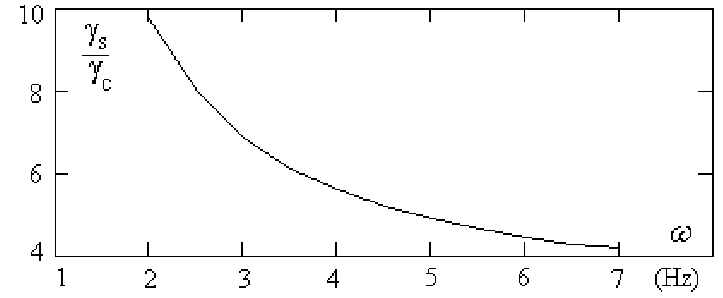
Fig. 4. The ratio γ s / γ c versus ω for EMIC waves in the hydrogen 1-D and 2-D plasma models. According to Eqs. (75-77), the PCI growth rate γ , as well as the imaginary part of the c transverse dielectric permittivity, is calculated by the summation of the contributions of the separate bounce resonant terms to . The typical structure of the bounce resonance terms , Eq. (77), is shown in Fig. 5 for the different wave frequencies a) . As we see, i) the contribution of the first bounce resonance terms to is very small; ii) the maximal values of correspond to the bounce resonance numbers numbers are shifted to left for the EMIC waves with a larger frequency.